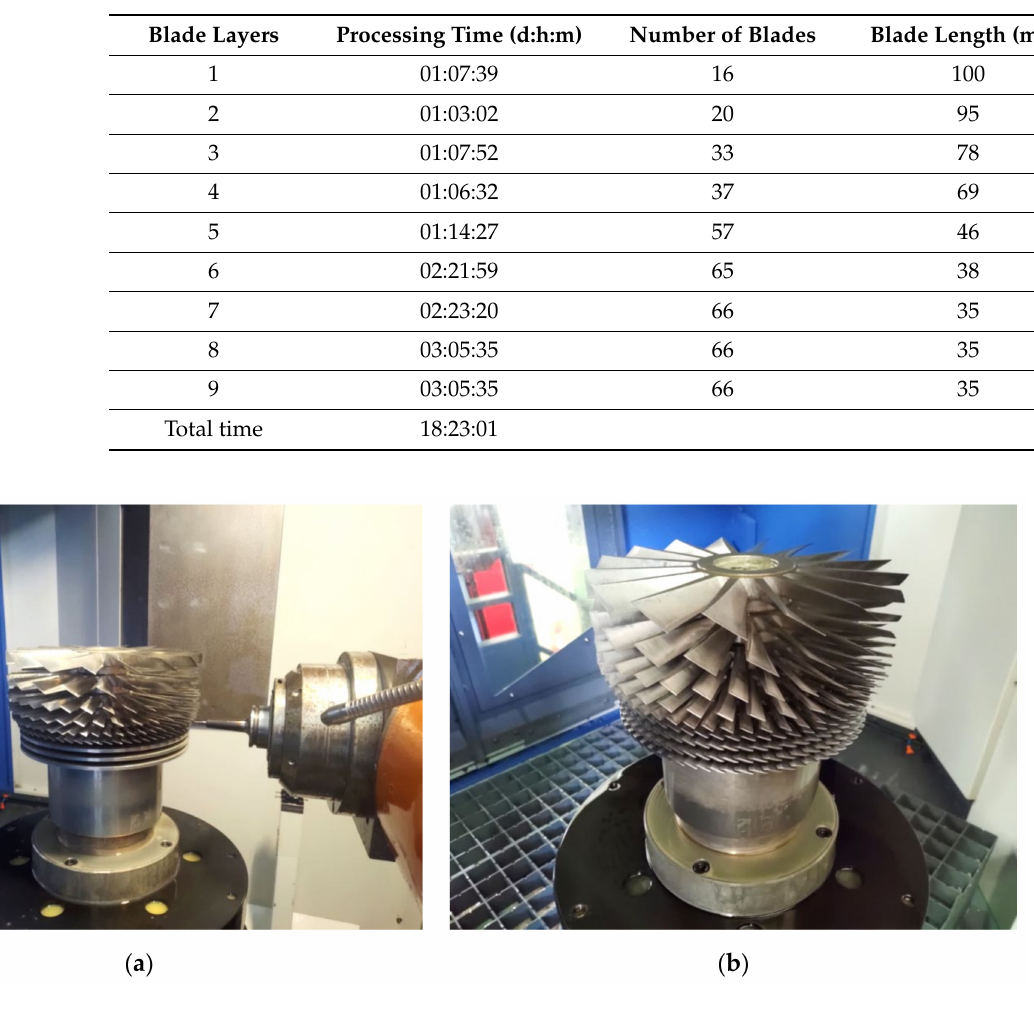
Figure 10. Final product of the turbomolecular pump rotor. ( a ) Rotor machining process; ( b ) final product of the turbomolecular pump